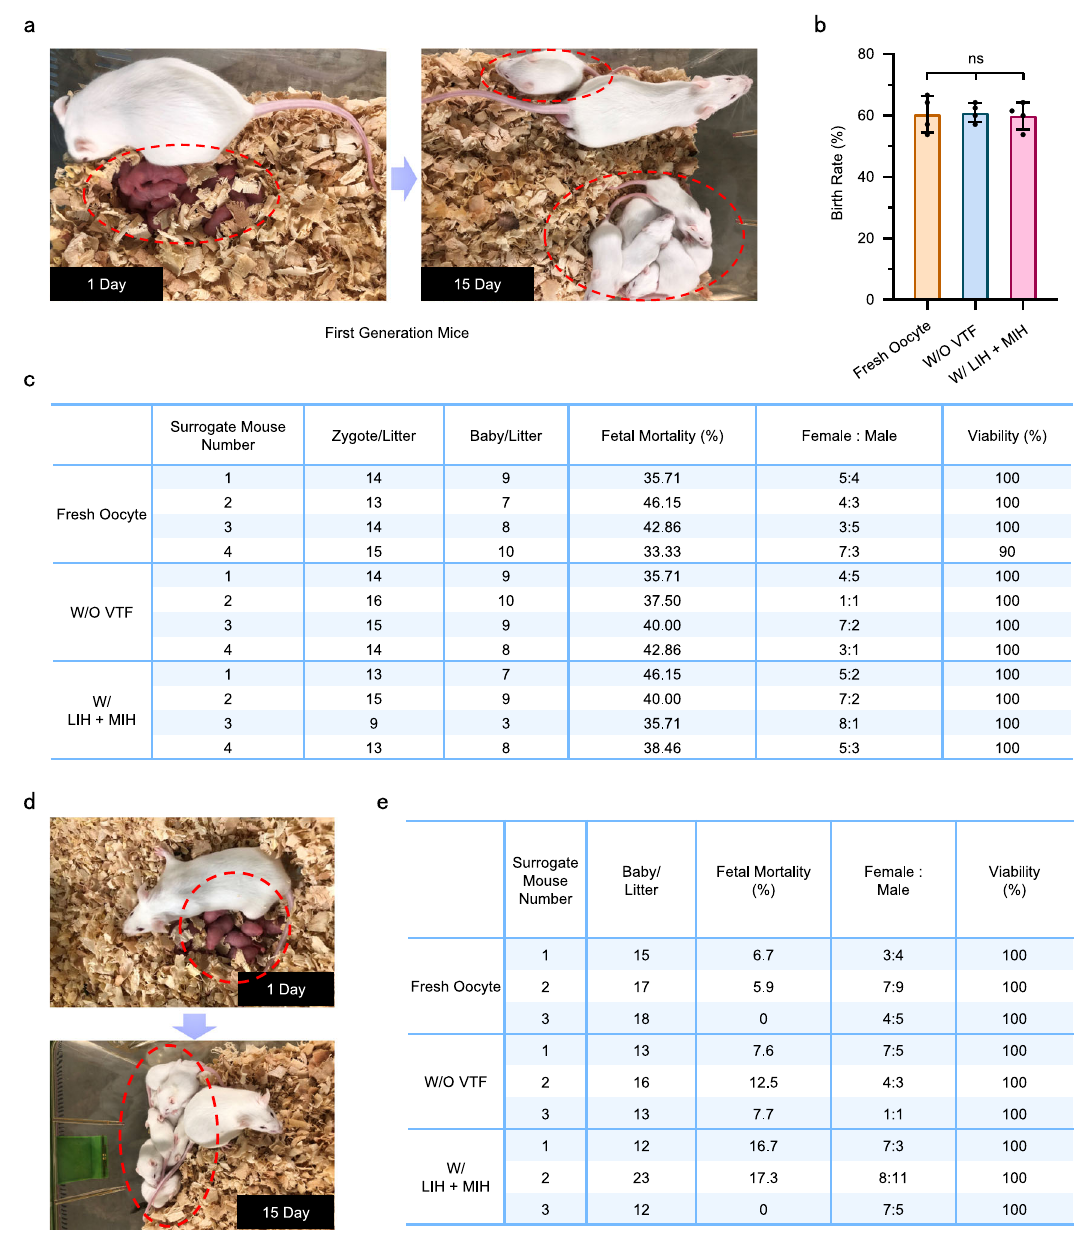
and LIH after vitri fi cation. Fresh oocytes: MII oocytes obtained directly from the ampulla of the oviduct of a mouse; One-way analysis of variance (ANOVA) and Tukey ’ s post hoc were used for statistical analysis ( b ). ns: p >0.05. n =10 – 20 for four replicates ( b ). n: number of follicles used in each experiment. Data are pre- sented as the mean±SD ( b